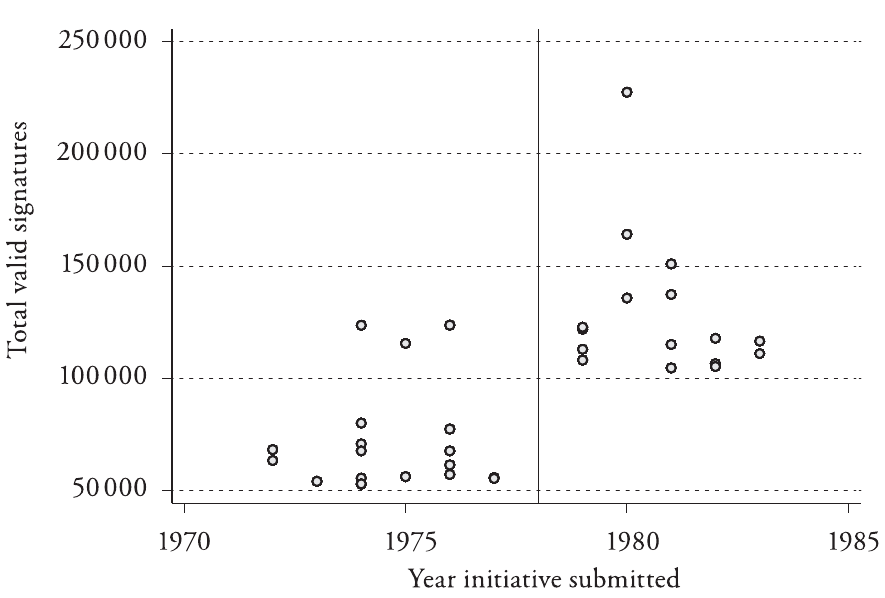
Figure 1: Total Valid Signatures